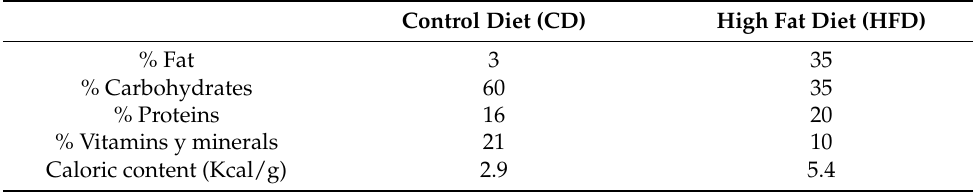
Table 2. Composition and calorie content of the diets used in the study. Control Diet (CD) High Fat Diet (HFD) % Fat